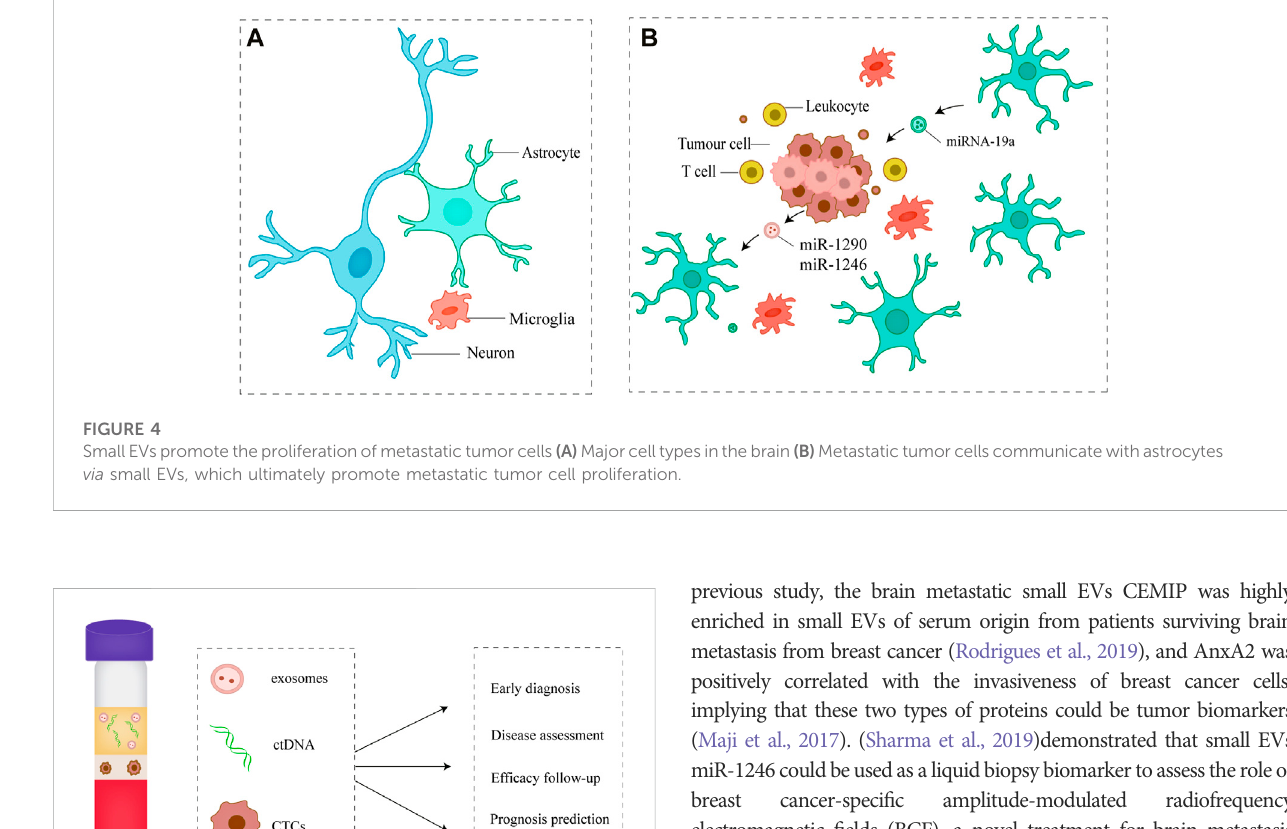
Liquid biopsy tools and the clinical